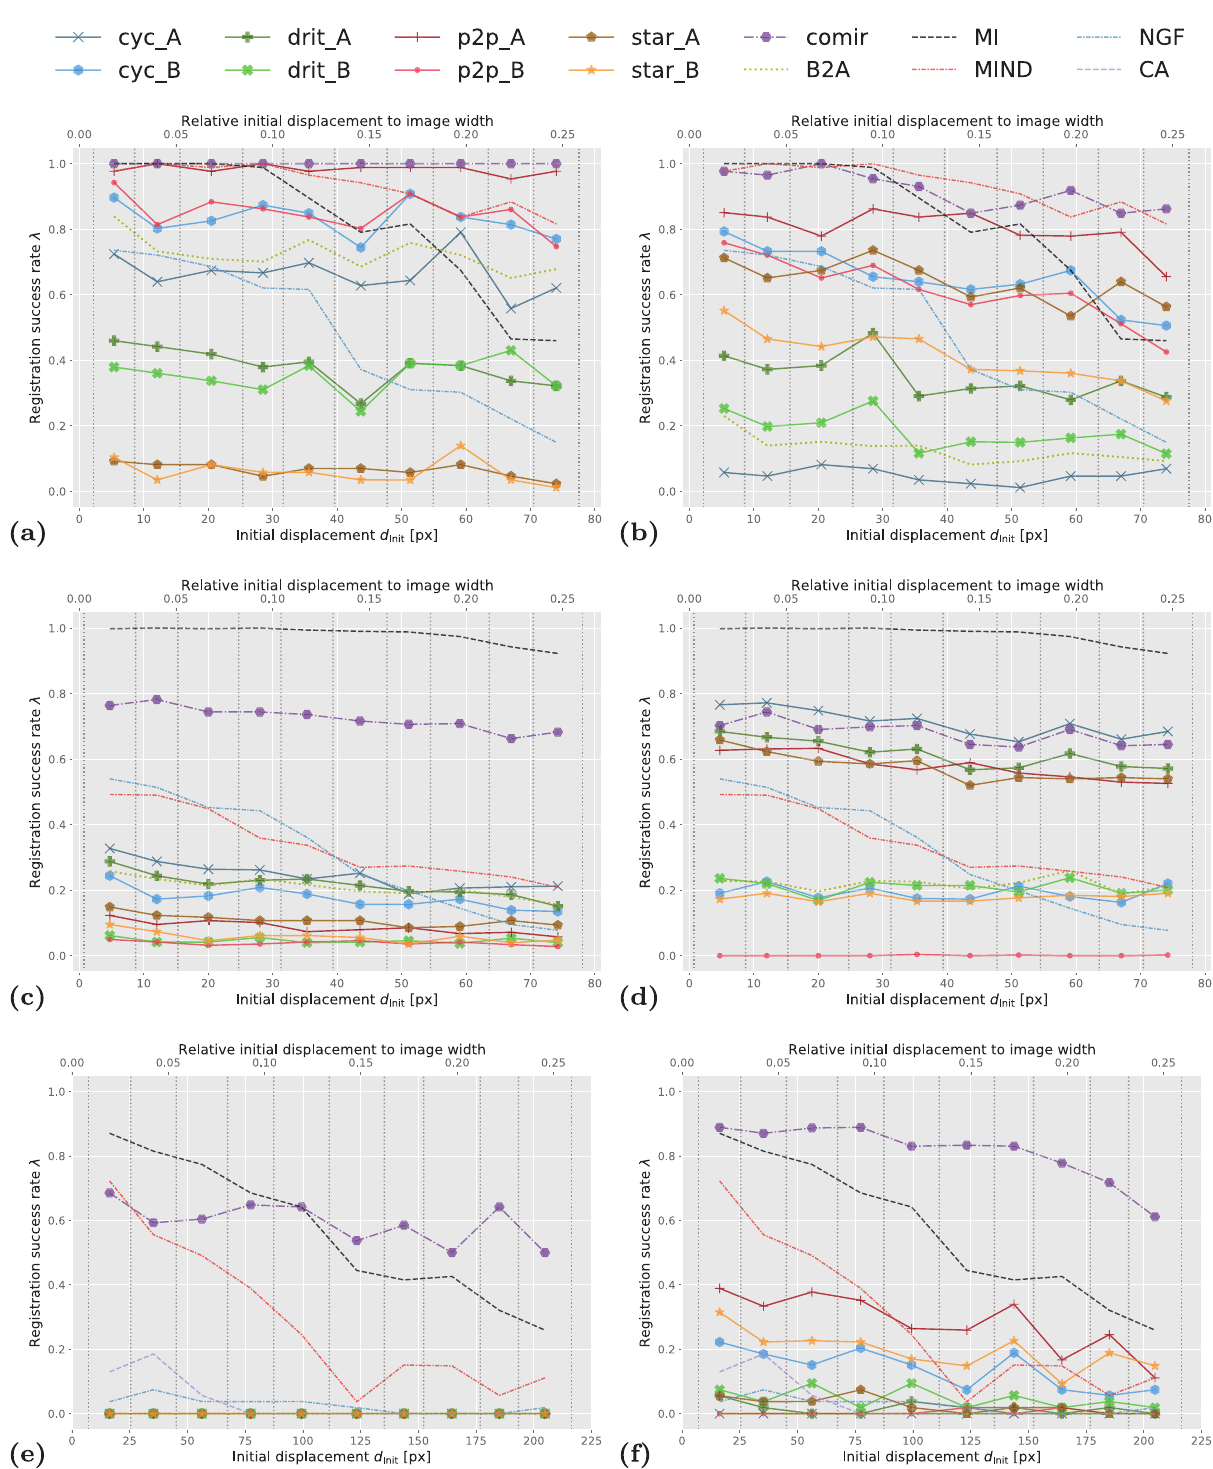
Fig 8. Success rate of the observed registration approaches. (A) SIFT on Zurich data, (B) α -AMD on Zurich data, (C) SIFT on Cytological data, (D) α -AMD on Cytological data, (E) SIFT on Histological data, (F) α -AMD on Histological data. x -axis : initial displacement d Init between moving and fixed images, discretised into 10 equally sized bins (marked by vertical dotted lines). y -axis : success rate λ within each bin (averaged over 3 folds for Zurich and Cytological data). In the legend, cyc , drit , p2p , star and comir denote CycleGAN, DRIT++, pix2pix, StarGANv2, and CoMIR methods respectively. Suffix _A (resp. _B) denotes that generated Modality A (resp. B) is used for the (monomodal) registration. B2A denotes registration of the